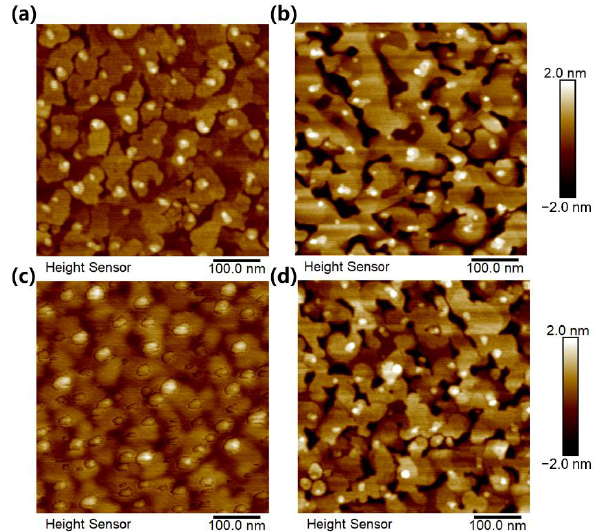
Figure 7. AFM images of sample S1 ( a ), R1 ( b ), S2 ( c ), and R2 ( d ), where white spots are QD − like centers.